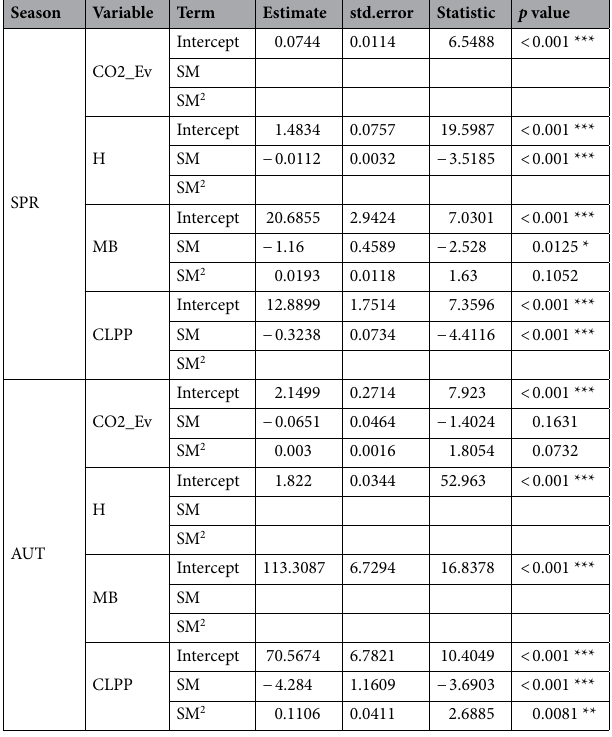
Table 5. Effect of SM on CO2_Ev, H’, MB and CLPP in each of two seasons. In each of the eight cases, the terms included in the best model (i.e., lowest AICc) are given in three separate rows (Intercept, SM, SM 2 ). Where a given term was not included in the best model, the row was left blank.